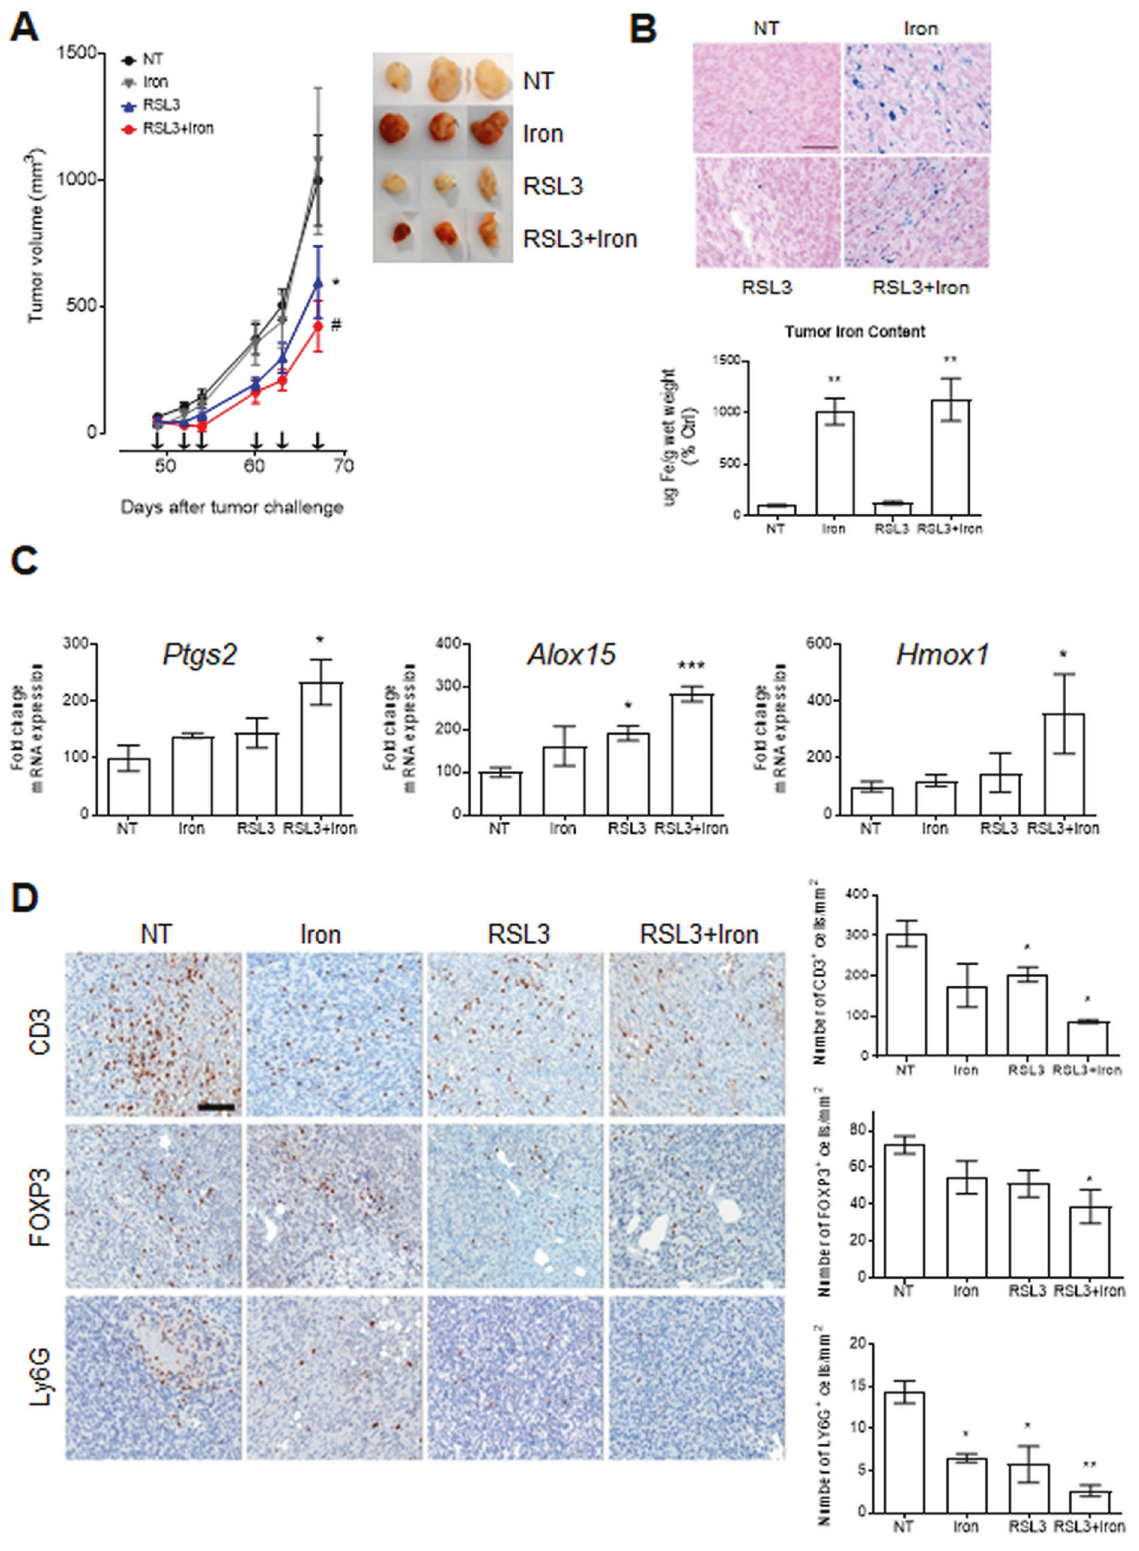
Fig. 4 RSL3 + iron impairs PCa growth in vivo. A In vivo growth of subcutaneous TRAMP-C2 tumors treated i.p. with iron dextran 200 mg/kg twice/week, RSL3 40 mg/kg twice/week or RSL3 + iron and compared with untreated (NT) ones. B Prussian Blue staining (blue dots) and total iron content assay on tumor samples. Data are expressed as % fold change over the not treated (NT). C qPCR of ferroptosis related genes in tumor samples. Data are expressed as % fold change over the not treated (NT). D Immunohistochemistry and quanti fi cation of immune populations (CD3, FOXP3 and Ly6G markers) in tumor samples expressed as positive cells/mm 2 . Data are the mean ± SEM of 8 – 10 tumors/ group. * p < 0.05, *** p < 0.001, # p < 0.0001 refers to each group vs NT group. Scale bar = 100 μ m.